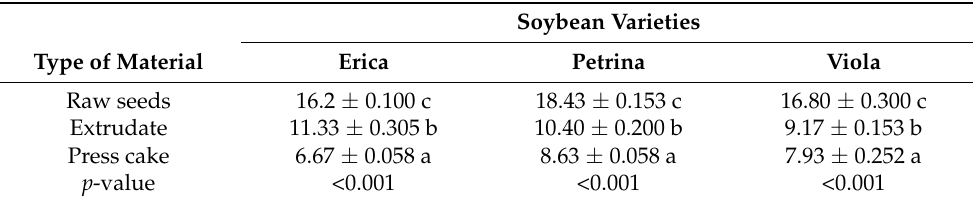
Table 4. The content of trypsin inhibitors (mg · g − 1 feed) in the raw soybean seeds and in the feed products subjected to technological processes.